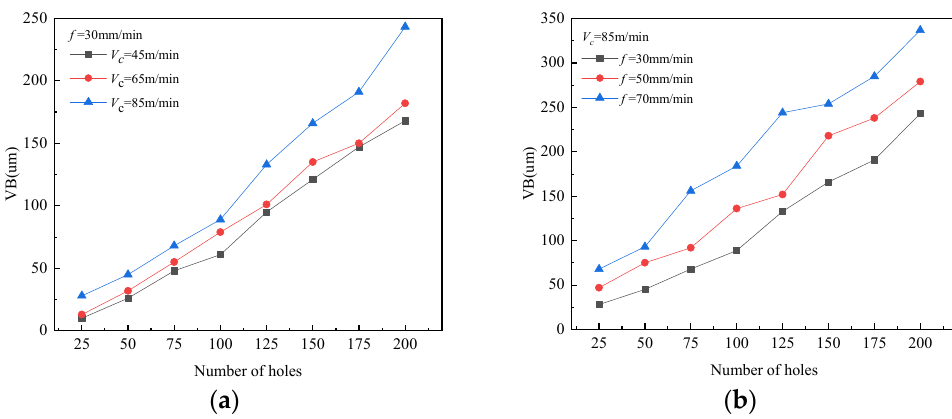
Figure 9. VB at different drilling parameters: ( a ) different cutting speeds; ( b ) different feed rates.